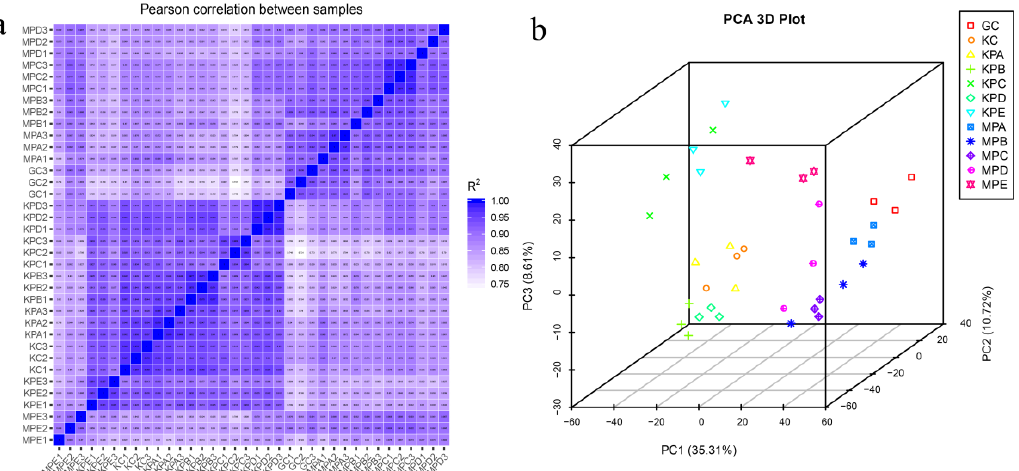
Figure 3. The number of DEGs produced at 5 time points after inoculation with the control (0 h). K- up: upregulated genes in HZ2399; K-down: downregulated genes in HZ2399; M-up: upregulated genes in SQ25; M-down: downregulated genes in SQ25.